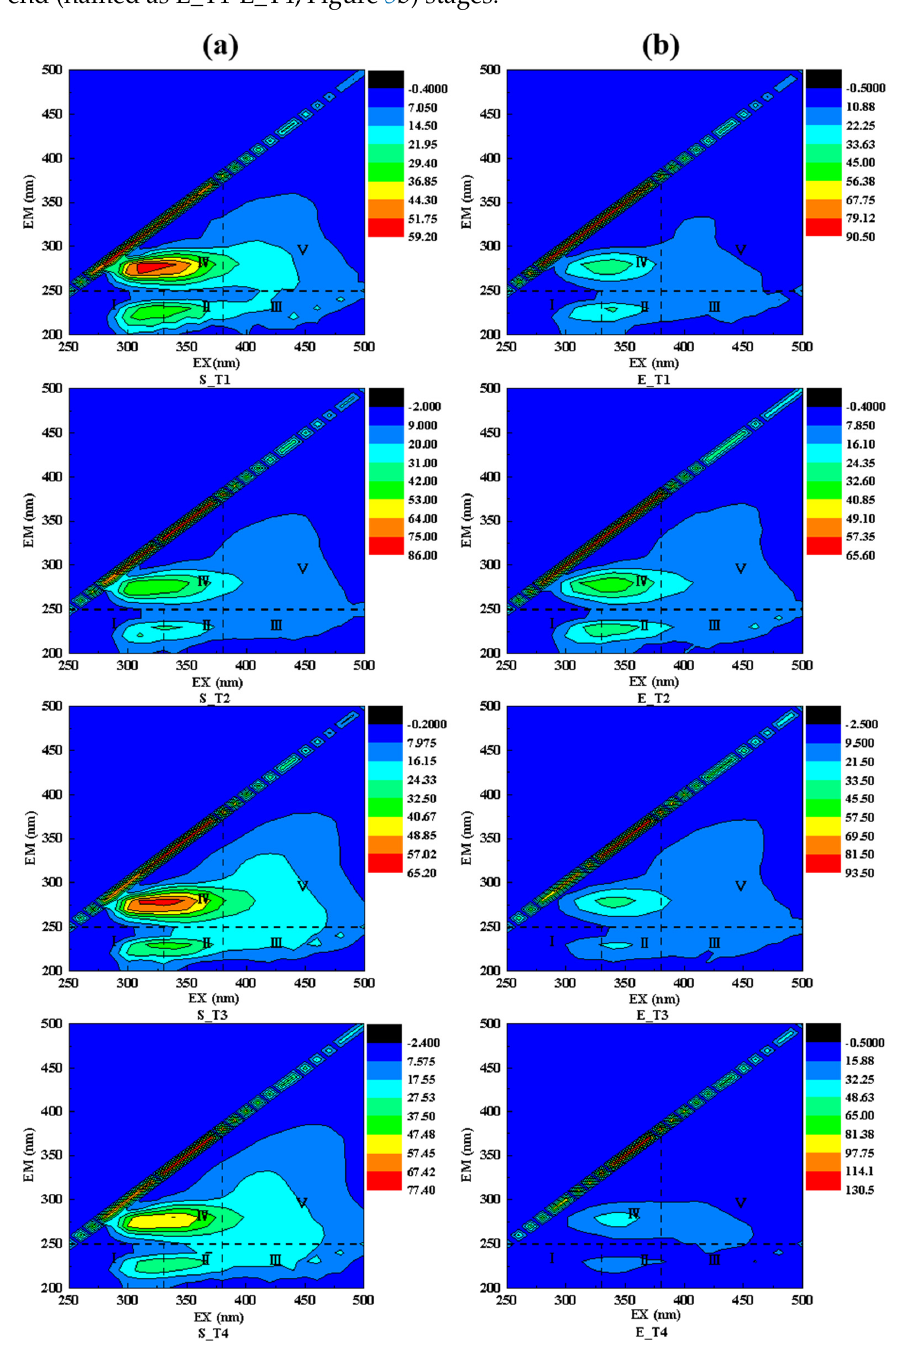
Figure 5. 3D-EEM of F-CS and D-CS digesters ( a ) at the stable period, and ( b ) at the end period.